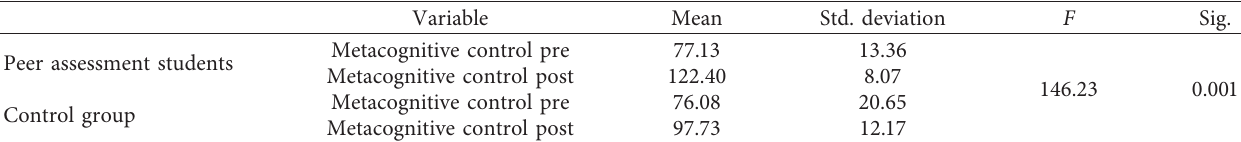
Table 6: The results of covariance analysis for the metacognitive control variable of peer assessment students.